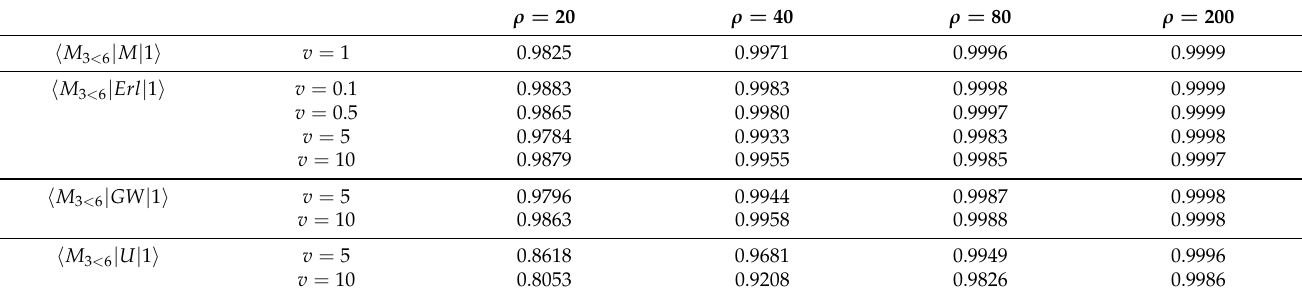
Table 2. K av of (cid:104) M 3 < 6 | GI | 1 (cid:105) system under quick